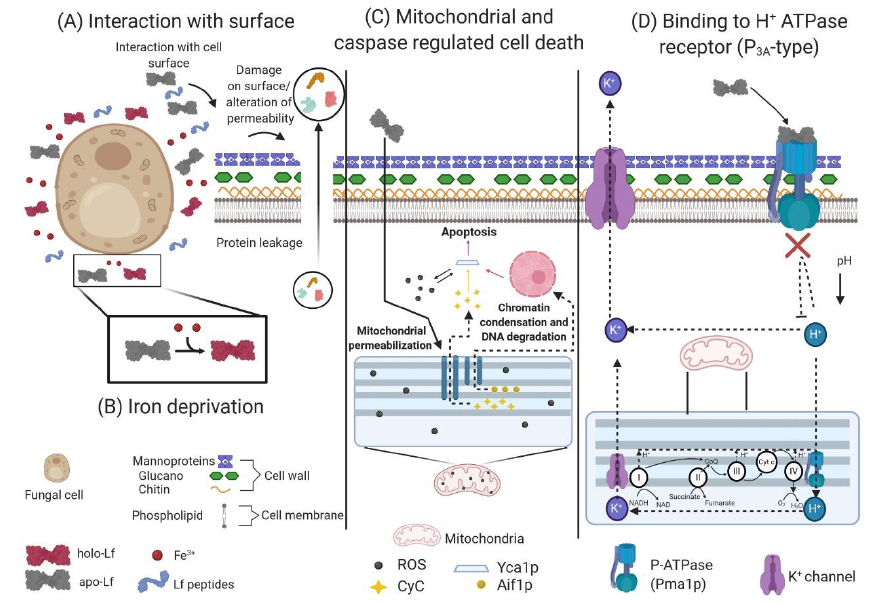
Figure 4. Mechanisms of the antifungal action of lactoferrin (Lf) and lactoferricins (Lfcins). ( A